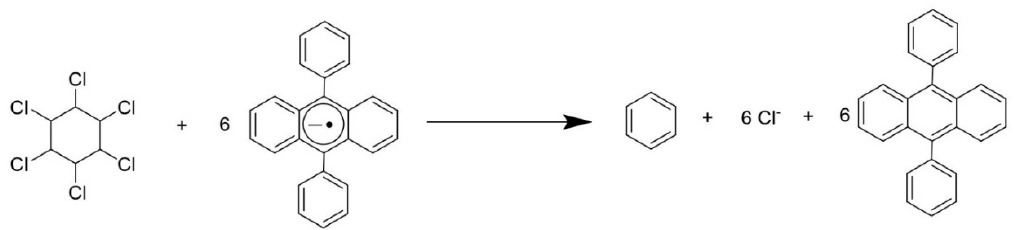
Figure 3. Proposed mechanism of 9,10-diphenylanthracene (DPA) mediated electrochemical reduction of Lindane [70].